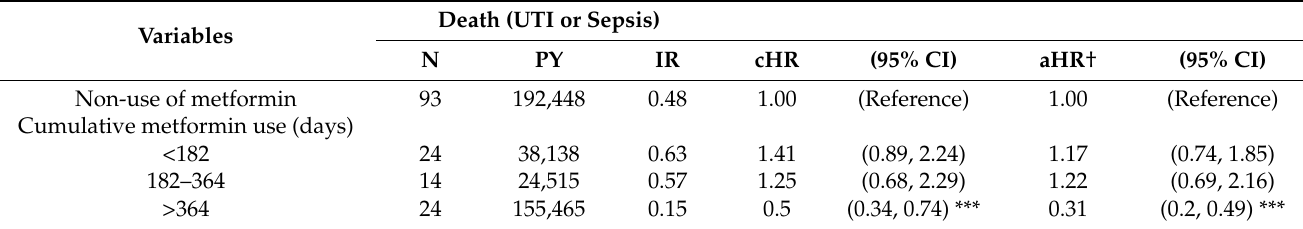
Table 4. Hazard ratio of death due to UTI or sepsis for stratification by the cumulative use of